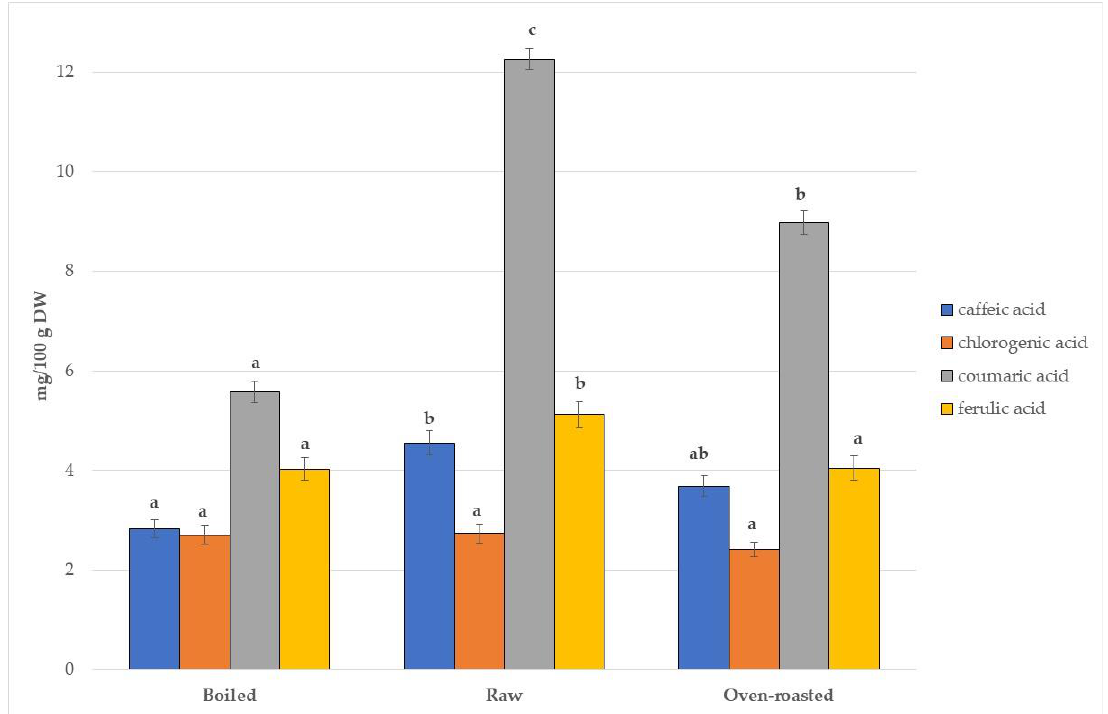
Figure 5. Profile of the cinnamic acids in the analysed chestnuts in relation to each heat treatment. Different letters for the considered groups indicate significant statistical differences ( p < 0.05) among different “cooking method” groups for each compound.